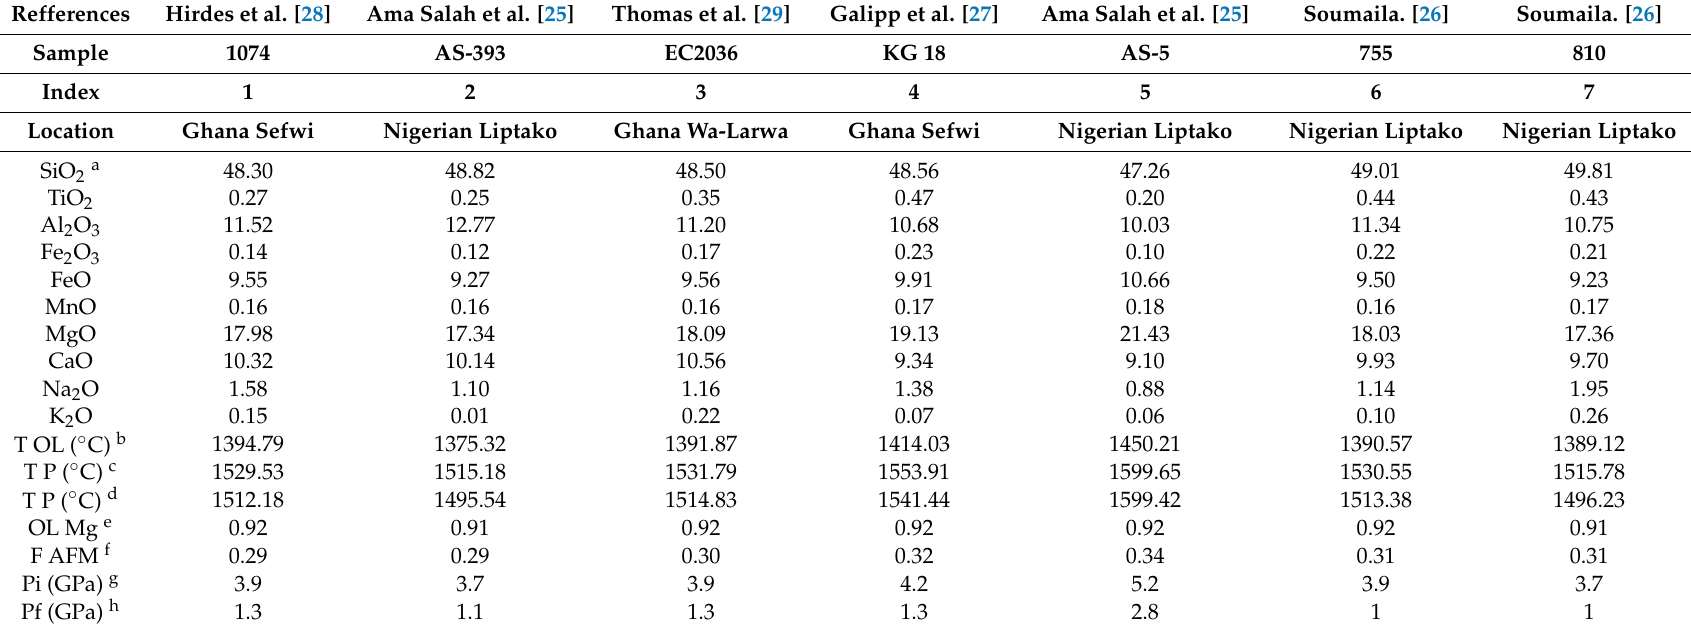
Table 1. Primary Magma Solutions for volcanic rocks in the West African Craton (WAC) (ca. 2.2–2.1